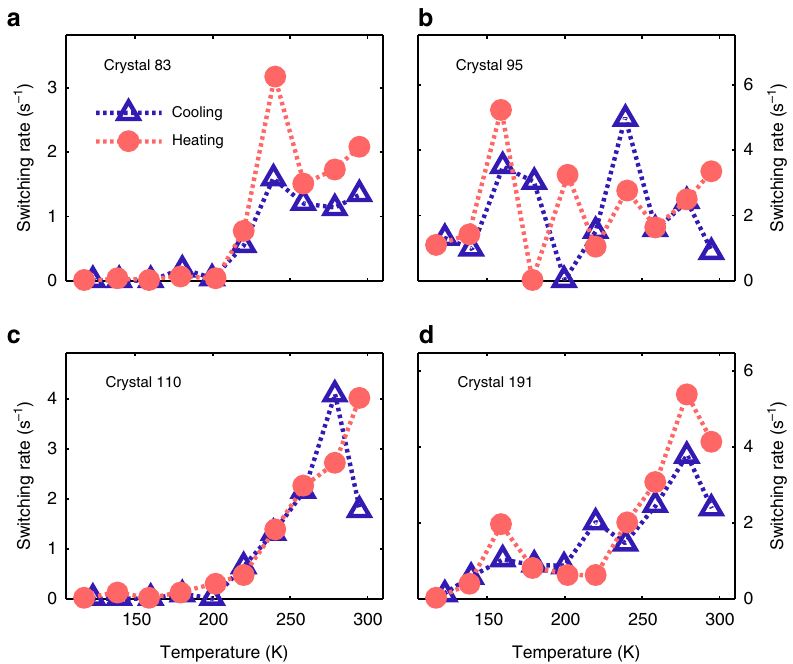
Fig. 4 Analysis of blinking dynamics extracted from the model traces. For calculation of the switching rates, all blink events with amplitudes larger than 20% of the mean intensity of a PL transient were considered. The number of events was counted and dividing by the measurement time of 100 s yielded the switching rates presented in this fi gure. The switching rates of the individual crystals presented here in panels ( a - d ) demonstrate distinct and reproducible temperature dependencies, for more examples see Supplementary Figure